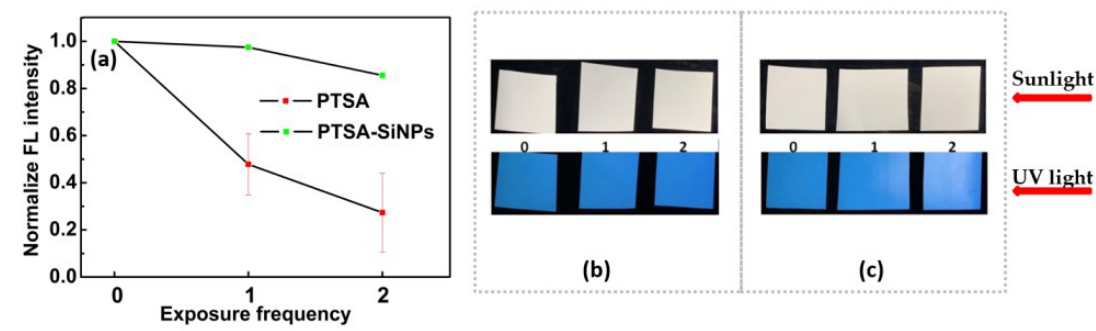
Figure 9. ( a ) Comparison of photostability of the PTSA-SiNP and PTSA anti-counterfeit ink; photostability photos of ( b ) PTSA-SiNP and ( c ) PTSA anti-counterfeit ink samples under sunlight and UV light (365 nm), respectively.